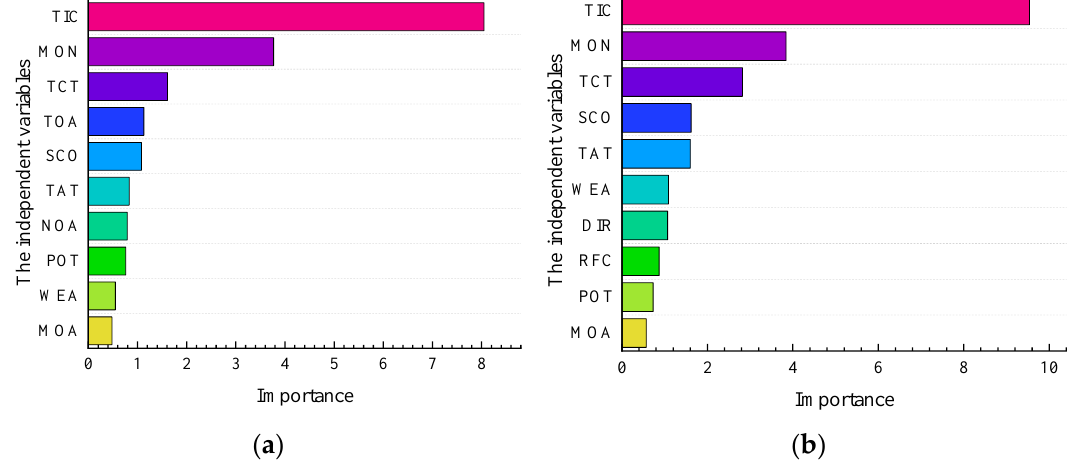
Figure 10. ( a ) The result of the RF model in the SSI area; ( b ) The result of the RF model in the NSI area.